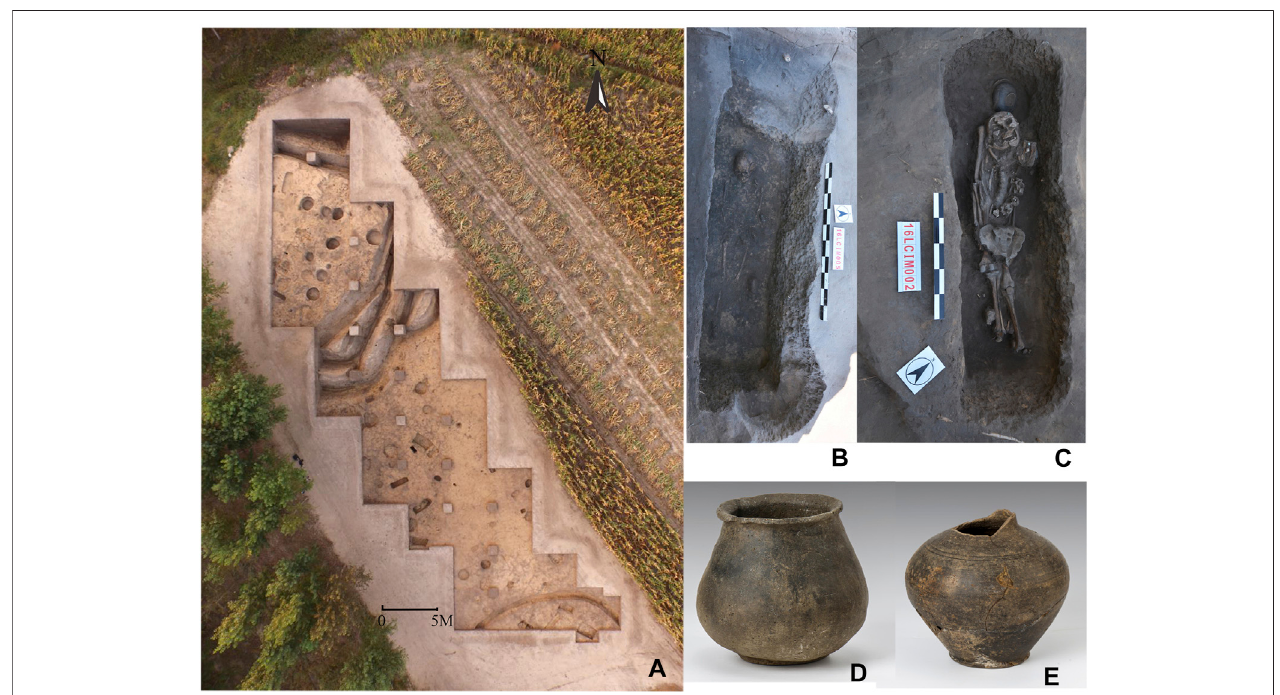
FIGURE2|(A) aerialphotographoftheexcavation areaoftheChangshansitein2016 (B) picture showingtop viewoftheburial ofoneBronze Ageindividual (C) a pottery vessel in the Bronze Age (D) picture showing top view of the burial of one Liaojin Dynasties individual (E) A pottery vessel in the Liaojin Dynasties.